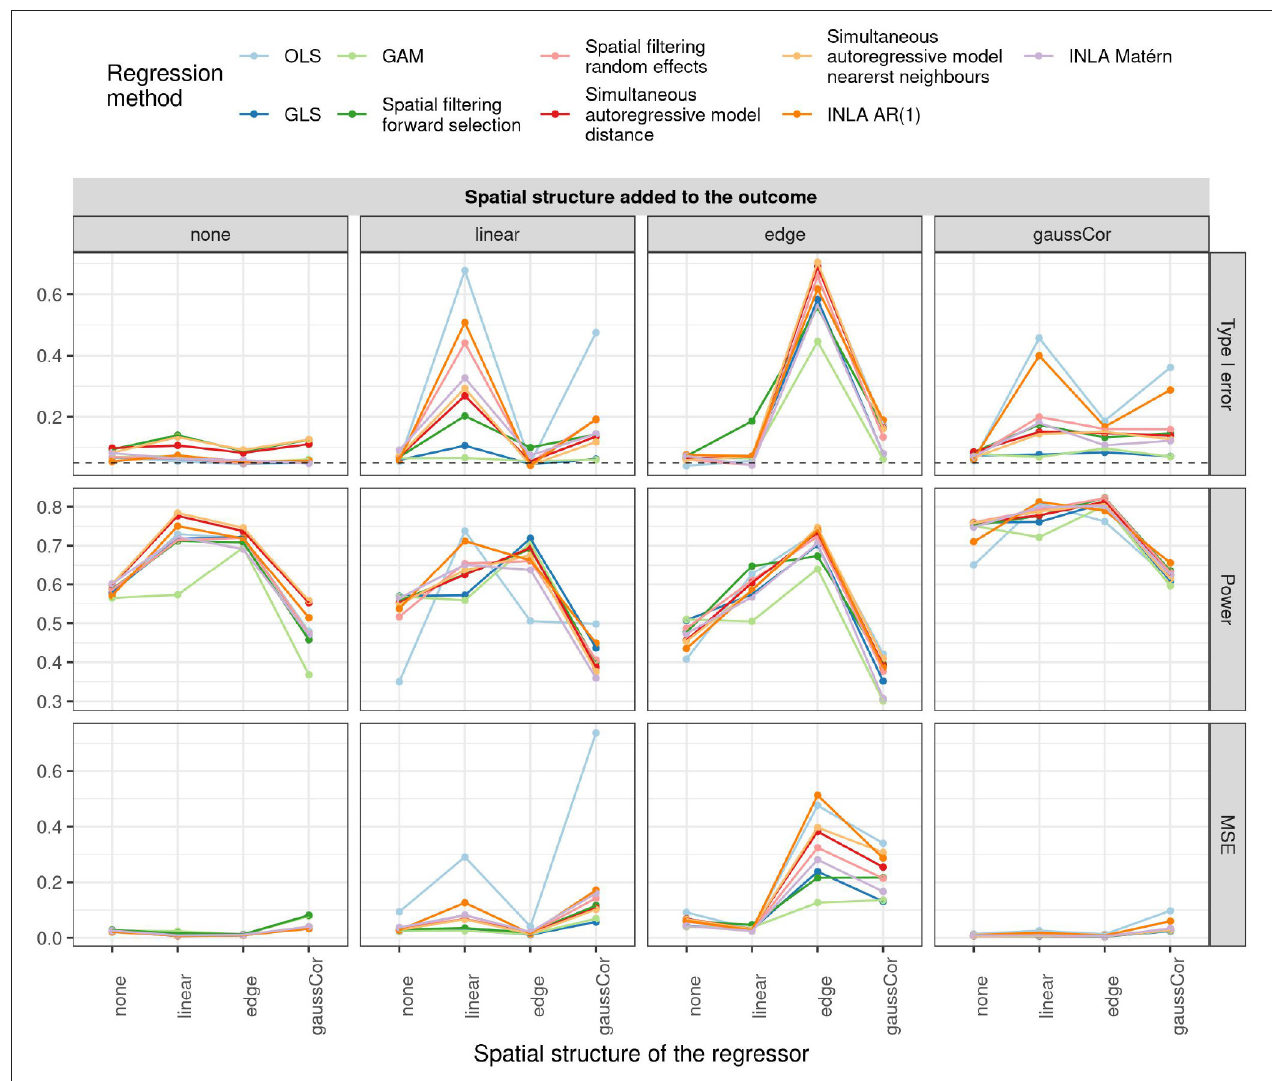
FIGURE 2 | Type I error (top), power (middle), and MSE of ˆ β (bottom) for the univariate observational study scenario for different regression methods (colors) and different spatial structures of the outcome (columns) and regressor (x-axis). The dashed horizontal line indicates the 5% significance